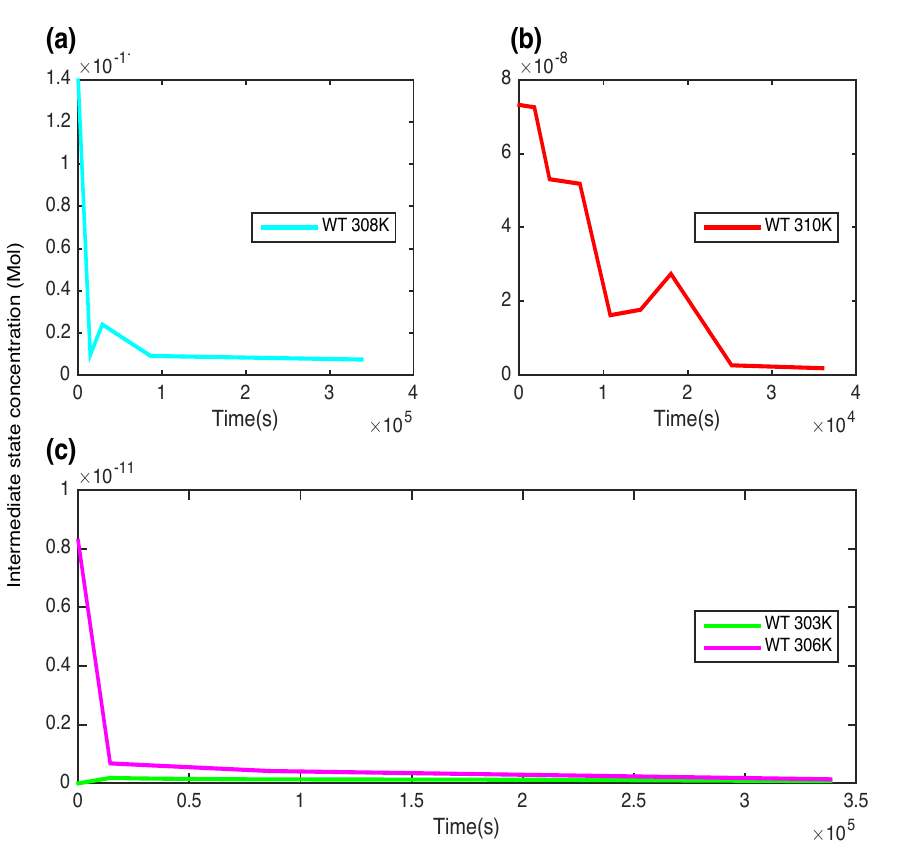
Figure 6. Curves demonstrating intermediate state concentration calculated from AKPE-derive kinetic parameters. ( a ) The change of wildtype intermediate concentration with time at 308 K. ( b ) Intermediate state curve at 310 K. ( c ) intermediate state curve at 303 K (green) and 306 K (pink). The unit of intermediate state concentrations are